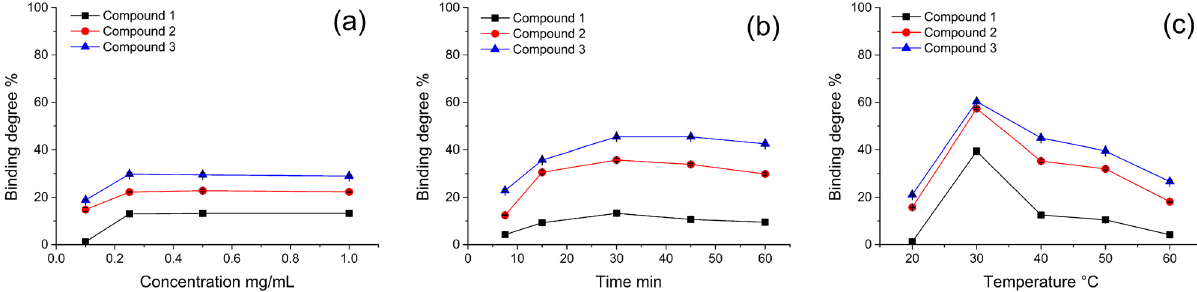
Figure 2: E ff ects of ( a ) concentration of enzyme, ( b ) incubation time, and ( c ) temperature on the screening e ffi ciencies of three